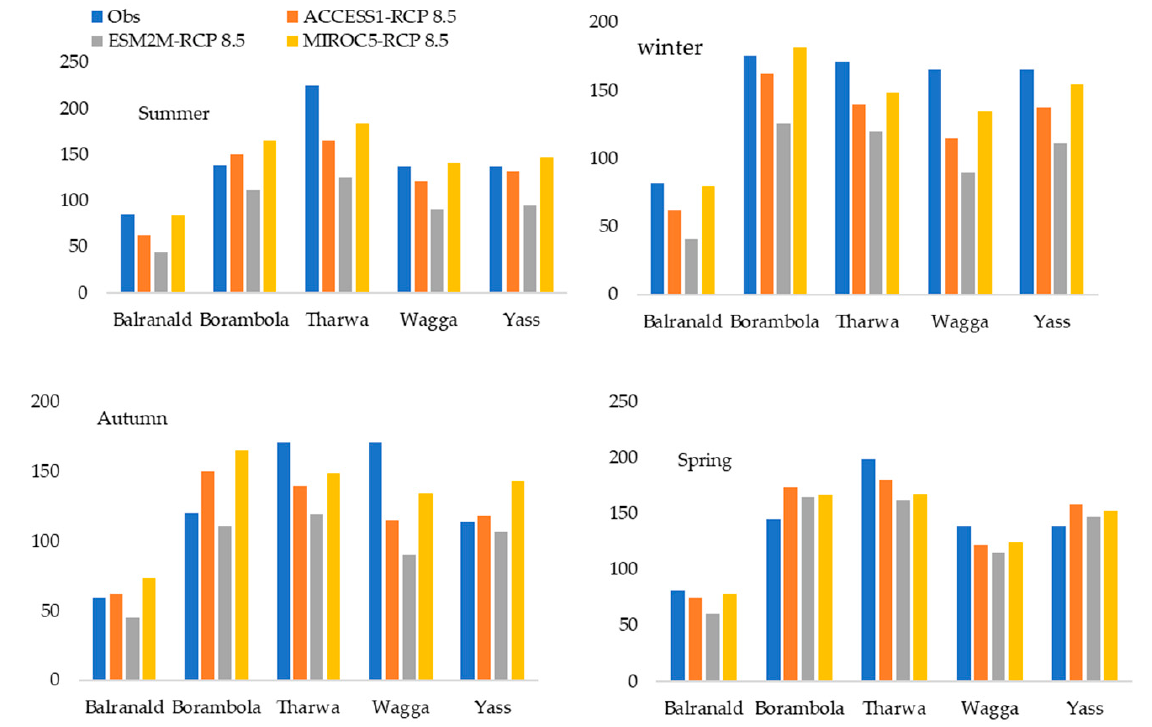
Figure 10. Predicted and observed seasonal rainfall for sub-catchments in the Murrumbidgee River basin under the RCP 8.5 climate scenario.